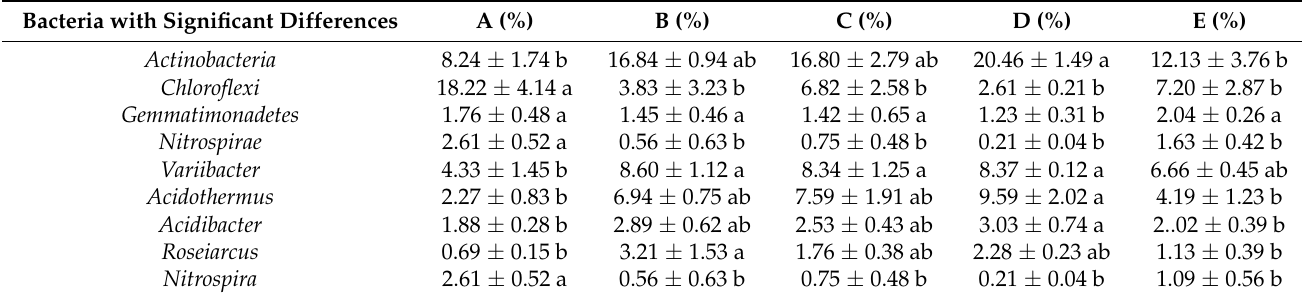
Table 2. Bacterial phyla and genera with significant difference among five